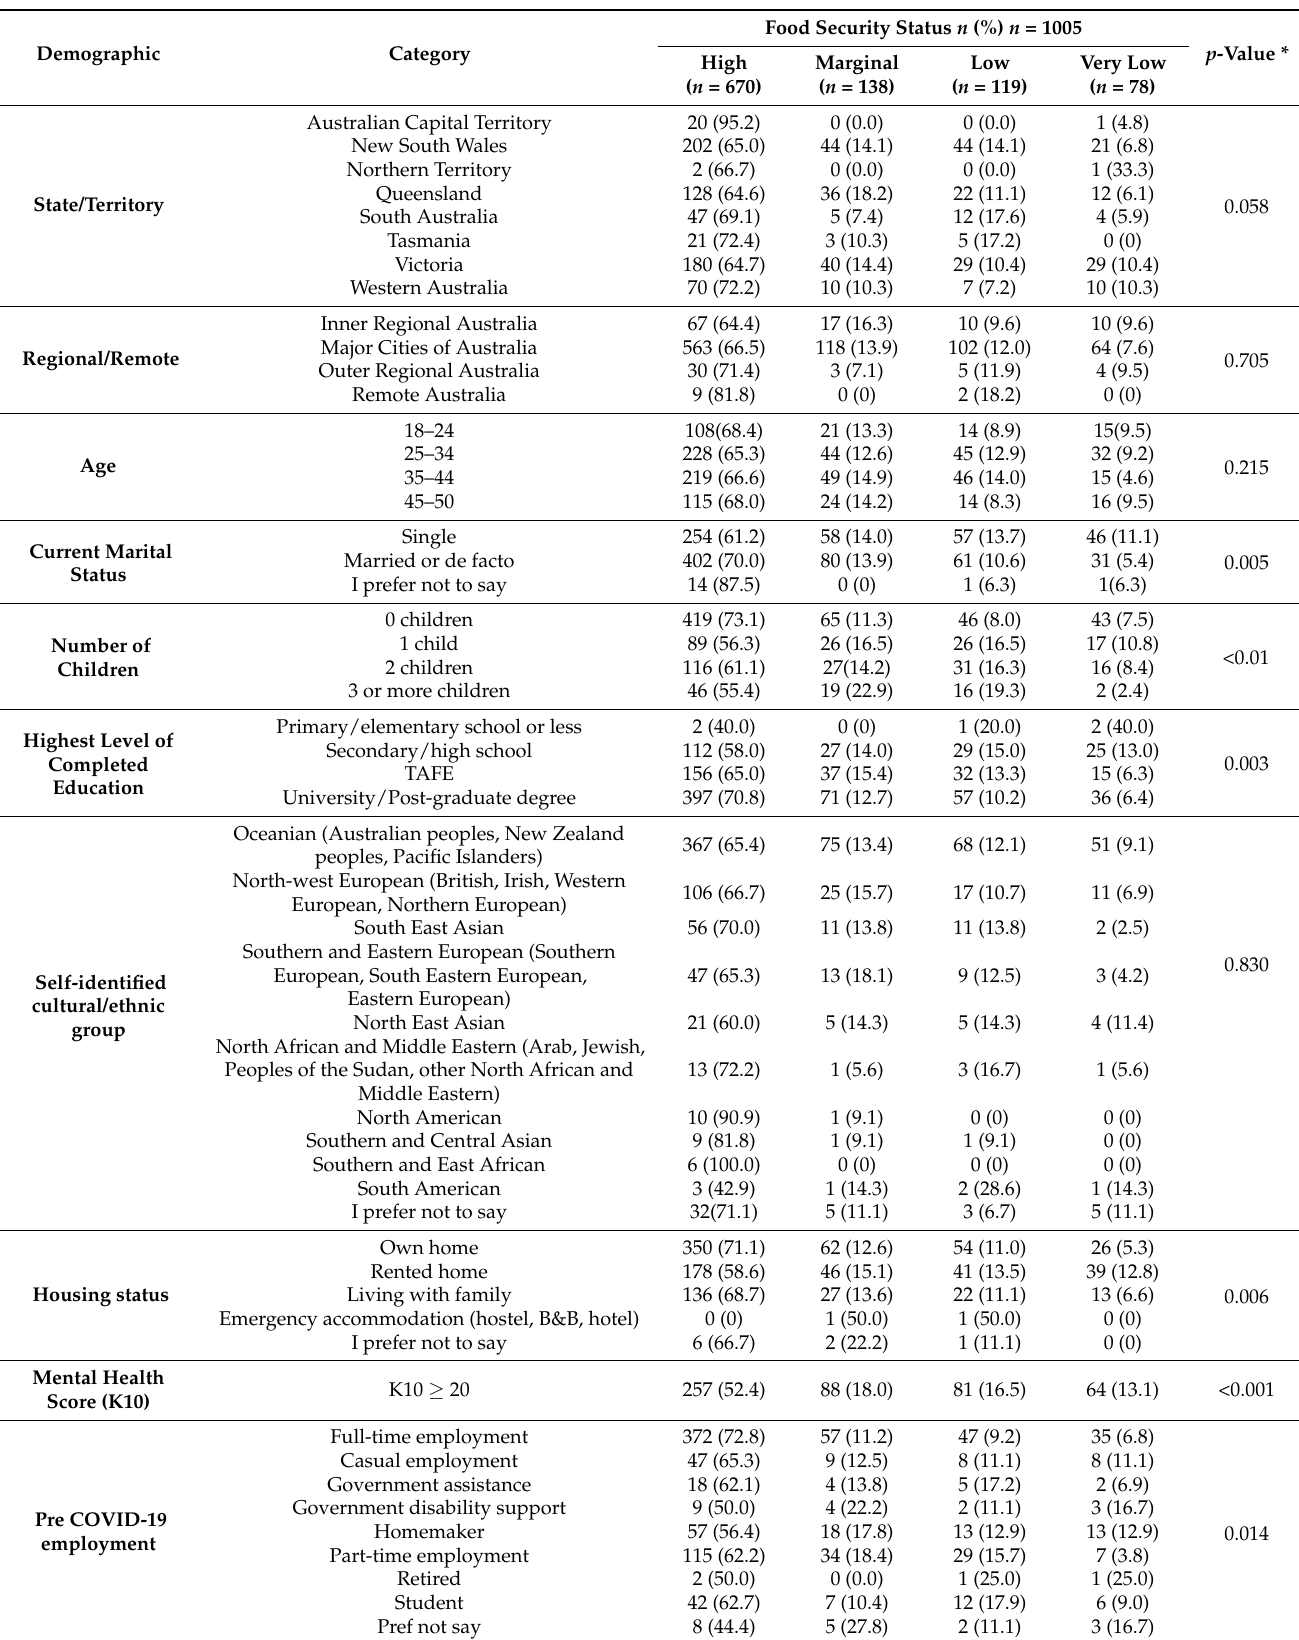
Table 1. Food security status by socio-demographic characteristics during COVID-19 in Australia in